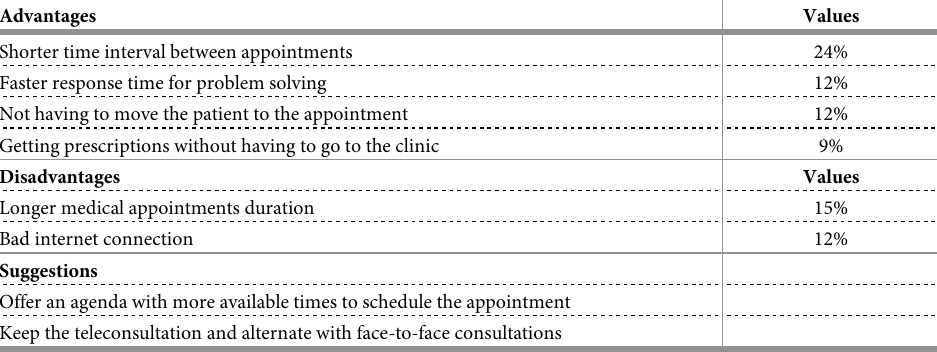
Table 5. Advantages, disadvantages, and suggestions of medical consultations online–telegeriatrics. Advantages Values Shorter time interval between appointments Faster response time for problem solving Not having to move the patient to the appointment Getting prescriptions without having to go to the clinic Disadvantages Longer medical appointments duration Bad internet connection